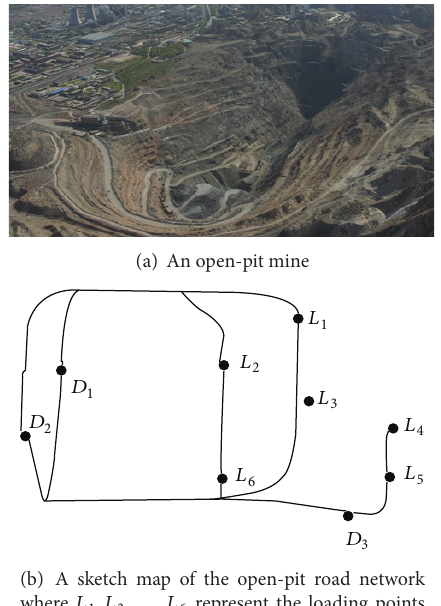
Figure 1: An open-pit mine and a part of its road network.